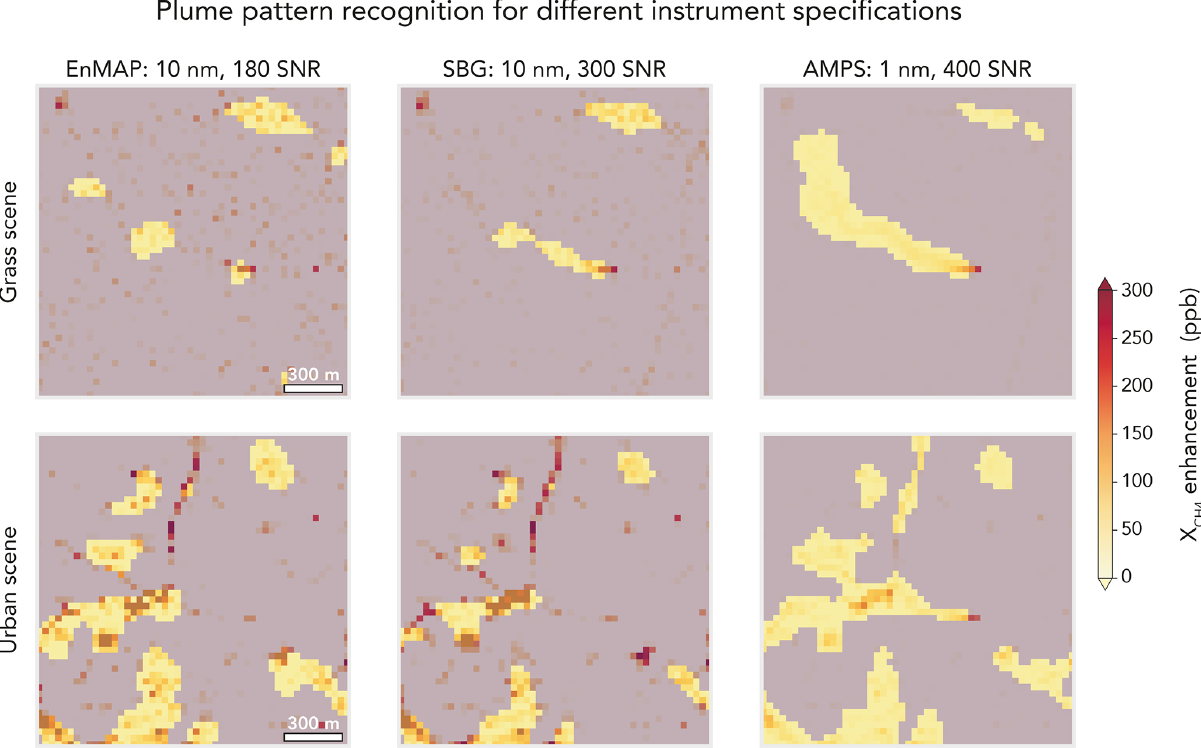
Figure 6. Plume pattern recognition algorithm applied to a point source of 500kgh − 1 over grass and urban scenes as shown in Fig. 3. The plume pattern is defined by applying median and Gaussian filters to pixels above the 80th percentile of X CH by the mask are shown in gray. The panels show retrievals from the EnMAP, SBG, and AMPS